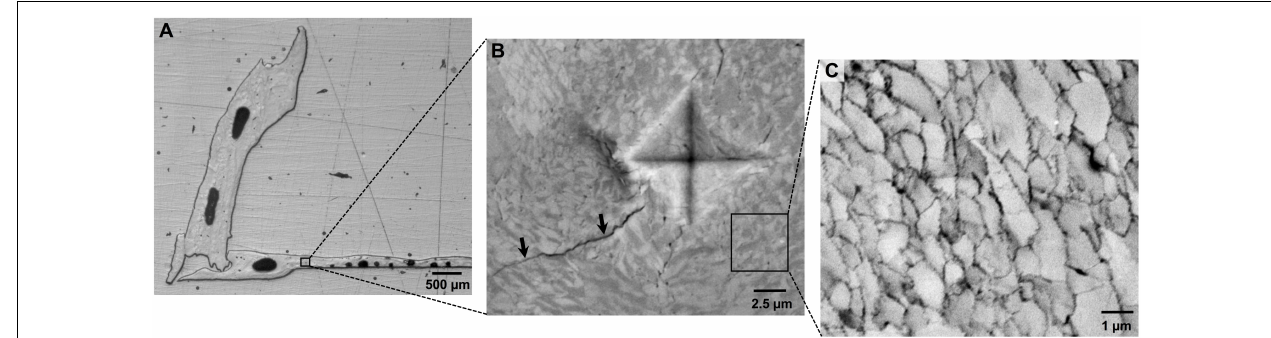
FIGURE 1 | (A) Assessments of barnacle shell properties were conducted on polished cross-sections of individual barnacle shells, which exposed both the base and parietal plates. (B) Mechanical testing was conducted using microindentation, which results in a diamond shaped indent and induces crack formation (arrows). Image was taken under polarized light, revealing organization of calcite crystals. (C) Shell ultrastructure was assessed using SEM. Shells are comprised of a cobblestone-like network of calcite crystallites, the area of which can be measured using image analysis